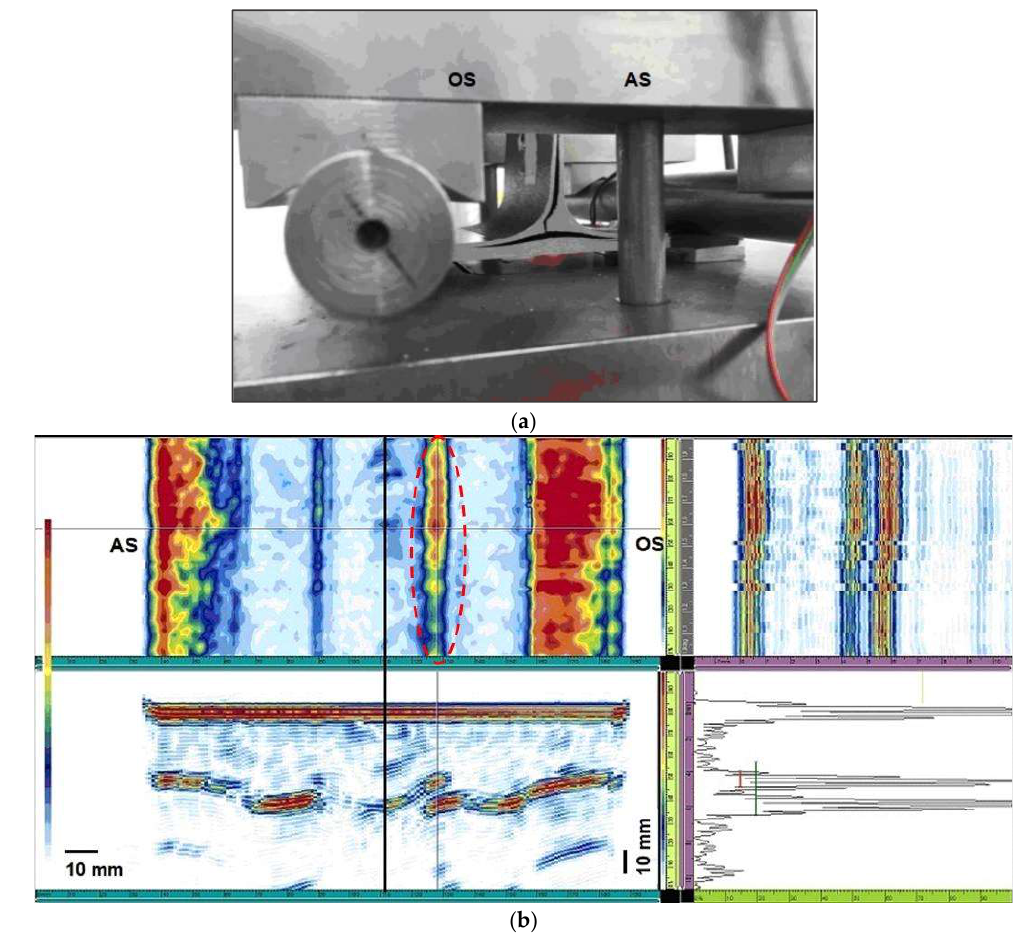
Figure 11. ( a ) Specimen 9 after delamination fracture; ( b ) UT images before the breaking; the red circle shows the continuous defected area.